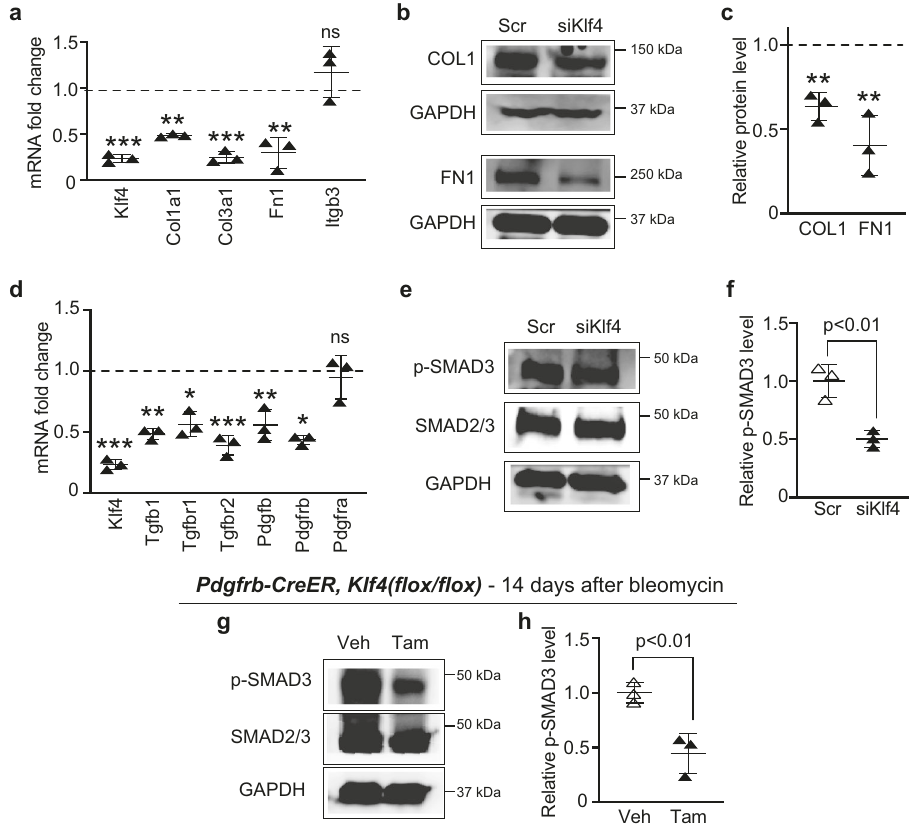
Fig. 4 Klf4 reduction in PDGFR- β + cells attenuates levels of TGF β pathway members and signaling and ECM components. a – f Zs + cells were isolated from the lungs of tamoxifen-induced Pdgfrb-CreER T2 , ROSA26R (Zs/ + ) mice and then subjected to siRNA-mediated knockdown with siKlf4 vs. scrambled (Scr). In a and d , levels of indicated transcripts relative to Gapdh were determined by qRT-PCR and normalized to Scr. n = 3 in triplicate. *, Tgfbr1 ( p = 0.017), Pdgfrb ( p = 0.010); **, Col1a1 ( p = 0.0035), Fn1 ( p = 0.0042), Tgfb1 ( p = 0.0034), Pdgfb ( p = 0.0045); ***, Klf4 ( p = 0.0006), Col3a1 ( p = 0.0004), Tgfbr2 ( p = 0.0007); ns (not signi fi cant) vs. Scr. In b and e and c and f , western blots for indicated proteins and corresponding densitometry relative to GAPDH and normalized to Scr are shown, respectively. n = 3. **, COL1 ( p = 0.0016), FN1 ( p = 0.0045) vs. Scr in b and p = 0.0057 in f . g, h Pdgfrb-Cre T2 , Klf4 ( fl ox/ fl ox) mice were induced with either vehicle (Veh; corn oil) or tamoxifen (Tam), rested, injected orotracheally with bleomycin, and 14 days later, lungs were harvested. Western blots of whole lung lysates for phosphorylated (p)-SMAD3, total SMAD2/3 and GAPDH are shown in g with densitometries of p-SMAD3 relative to SMAD2/3 and normalized to Veh ( h ). n = 3, p = 0.0095. Two-tailed Student ’ s t test was used for all analysis. Data are averages ± SD. Source data are provided as a Source Data fi